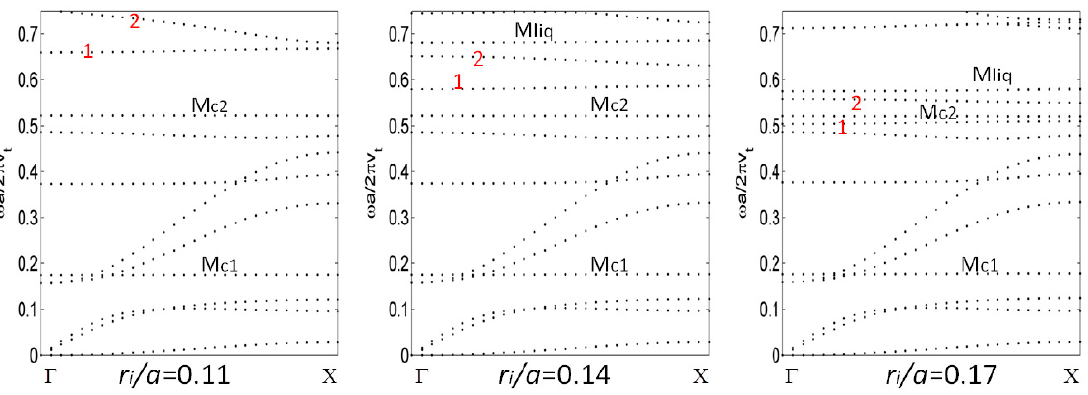
Figure 5. Dispersion curves of the hollow pillars on a thin silicon plate in the Γ X direction with different inner radii ( left ) r i /a = 0.11, ( middle ) r i /a = 0.14, ( right ) r i /a = 0.17. The other geometric parameters are h/a = 0.45, r/a = 0.4, l/a = 0.2.